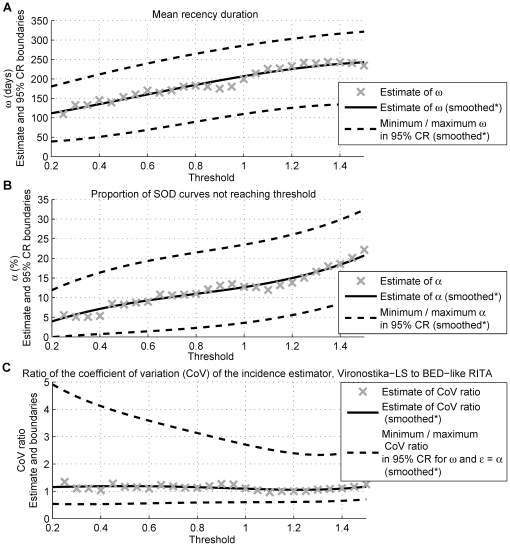
Performance of the Vironostika-LS for incidence estimation, based on estimated RITA characteristics.The estimated performance of the Vironostika-LS, for incidence estimation purposes, is shown, based on estimated RITA characteristics for the South African repeat donor population. In Part A and Part B, estimates of ω and α, respectively, under the simultaneous estimation of these parameters, for T = 1 year, are plotted as a function of test threshold. The minimum and maximum ω and α occurring in the 95% confidence regions (CRs) for these parameters are also displayed. In Part C, the estimated precision of the incidence estimator using the Vironostika-LS is compared to the precision obtained by a BED-like RITA (ω = 155 days and ε = 5.6% [34]), based on the estimated RITA characteristics (assuming ε = α) and assuming constant HIV incidence of 1.5% and prevalence of 17.5%. More specifically, the ratio of the coefficient of variation (CoV, ratio of standard deviation to mean) of the incidence estimator, for the Vironostika-LS to the BED-like RITA, is plotted as a function of the Vironostika-LS test threshold. *A polynomial is fitted by least squares to smooth estimates.